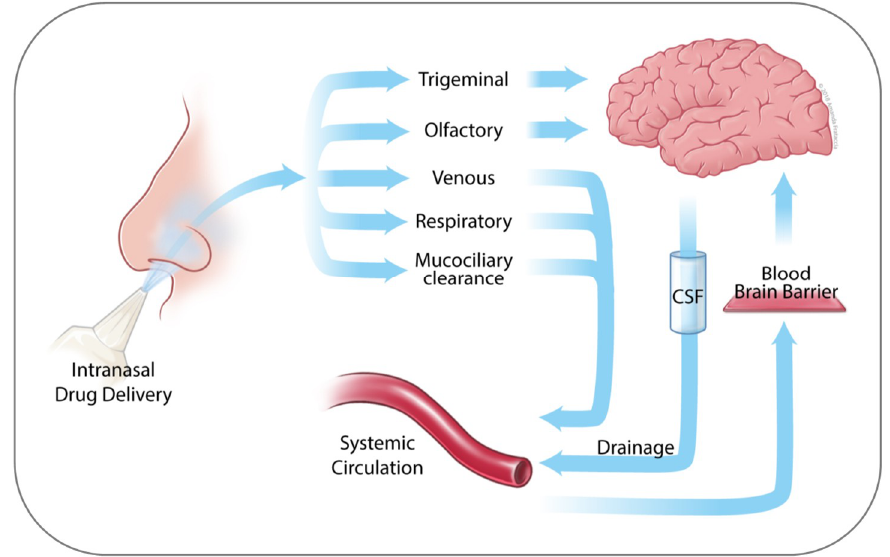
Figure 2. Pathways available to drugs for potential transport to the brain. Trigeminal and olfactory nerves offer direct nose-to-brain transport options. Venous and respiratory pathways, as well as mucociliary clearance, deliver drugs into the systemic circulation, where brain uptake is limited by BBB function. Clearance of drugs from the brain is achieved by several mechanisms, including drainage from the CSF, metabolism by brain-localized cytochrome P450 enzymes, and passing into the systemic circulation [55,56]. (Artwork by Amanda Frataccia; © 2018 Amanda Frataccia, provided under CC BY-NC-ND